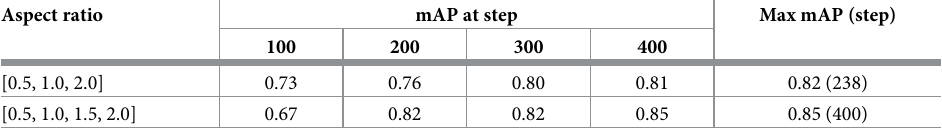
Performance comparison by mAP of the models trained using various aspect ratios with the scale [0.15, 0.3, 0.5, 1.0]. This performance was measured at 100, 200, 300, and 400 steps, and we identified the step at which the models achieved the best